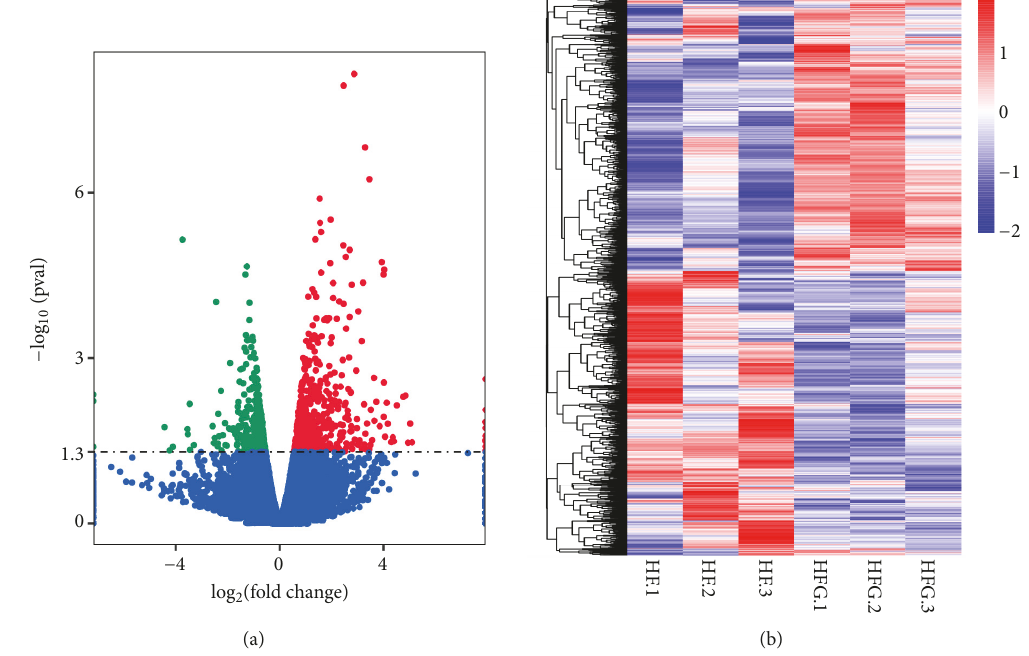
Figure 4: Dietary genistein could regulate gene expression in the hypothalamus. (a) The volcano plot graphs: this graph shows the log2 of the fold change in each gene’s expression between the two groups and its -log ( p value) from the t-test. The red indicates that the gene is upregulated, whereas the green indicates that gene is downregulated; and (b) heatmap diagram: this diagram illustrates the differential expression of hypothalamic mRNAs in the HF group (n = 3) compared with the HFG group (n = 3). The hierarchical clustering was based on 878 differentially expressed mRNAs. HF: high-fat diet without genistein; HFG: high-fat diet with